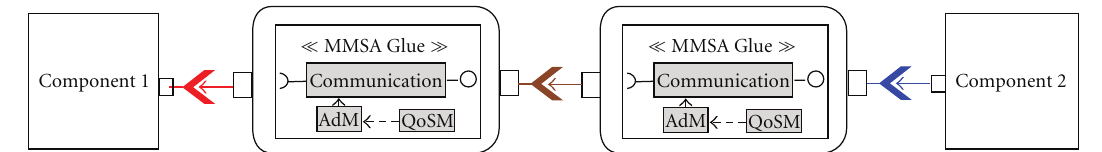
Figure 7: Two connectors of image transcoding JPEG to BMP to PNG.